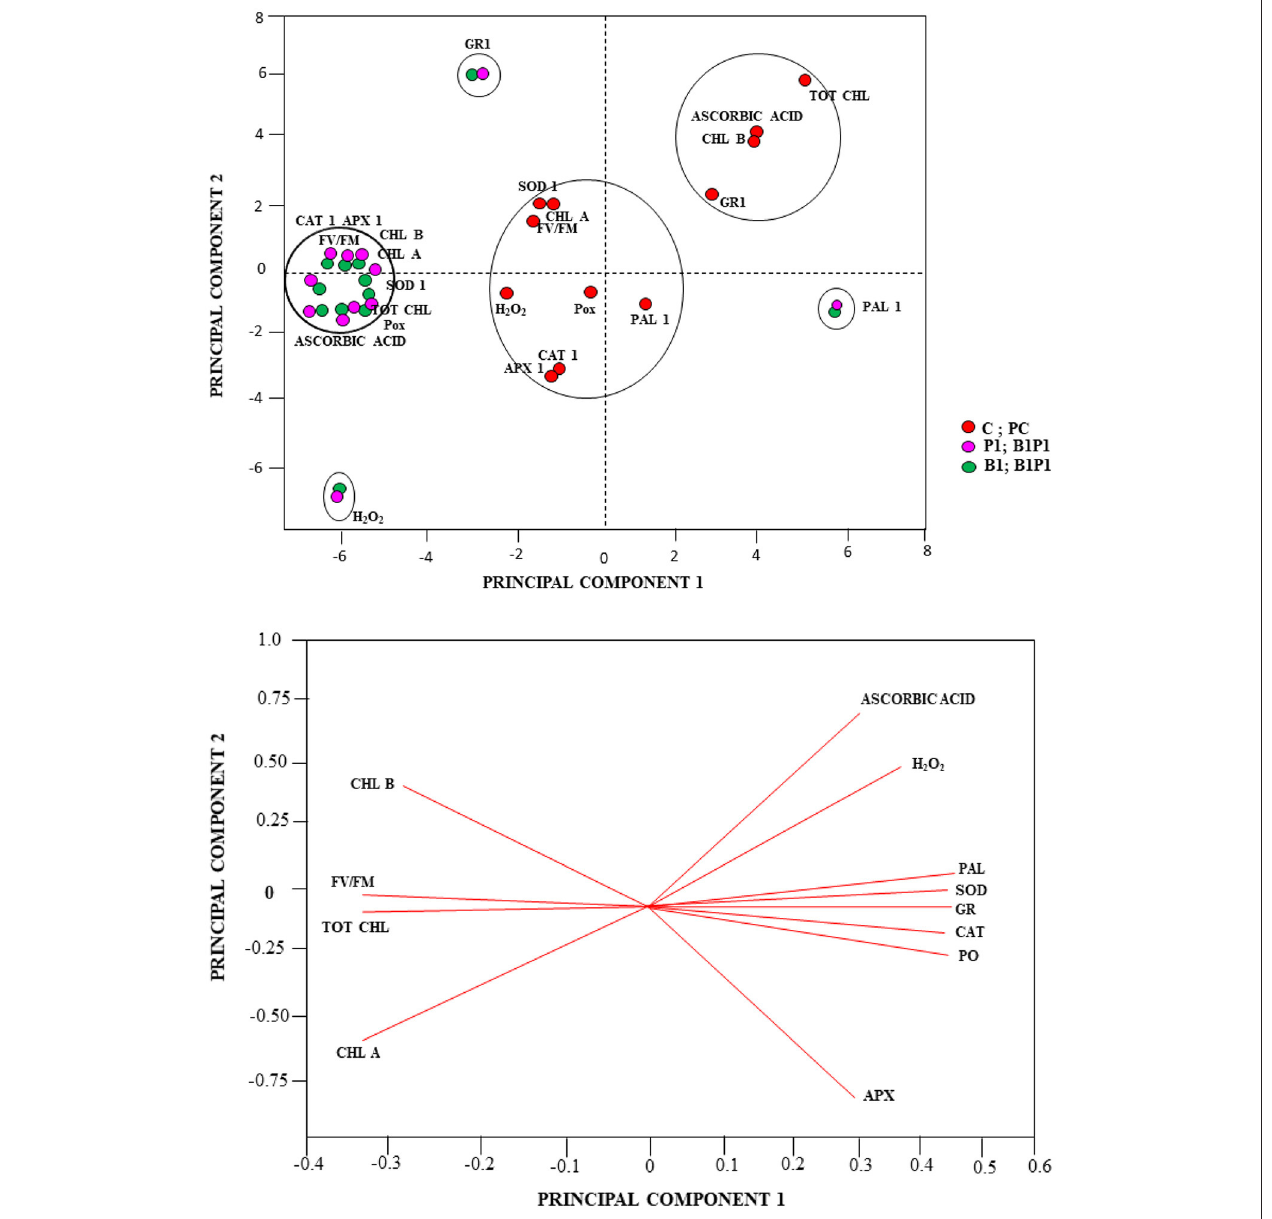
FIGURE 13 | PCA analysis (A) , Score plot and (B) , loading plot of the PCA linking the total chlorophyll (tot chl), chlorophyll b (chl b), chlorophyll a (chl a), chlorophyll a fluorescence parameter (maximum PSII quantum efficiency (Fv/Fm), H 2 O 2 , AA, peroxidase (POX1), ascorbate peroxidase (APX1), catalase (CAT1), superoxide dismutase (SOD1), glutathione reductase (GR1), and phenylalanine-ammonia lyase (PAL1) of different